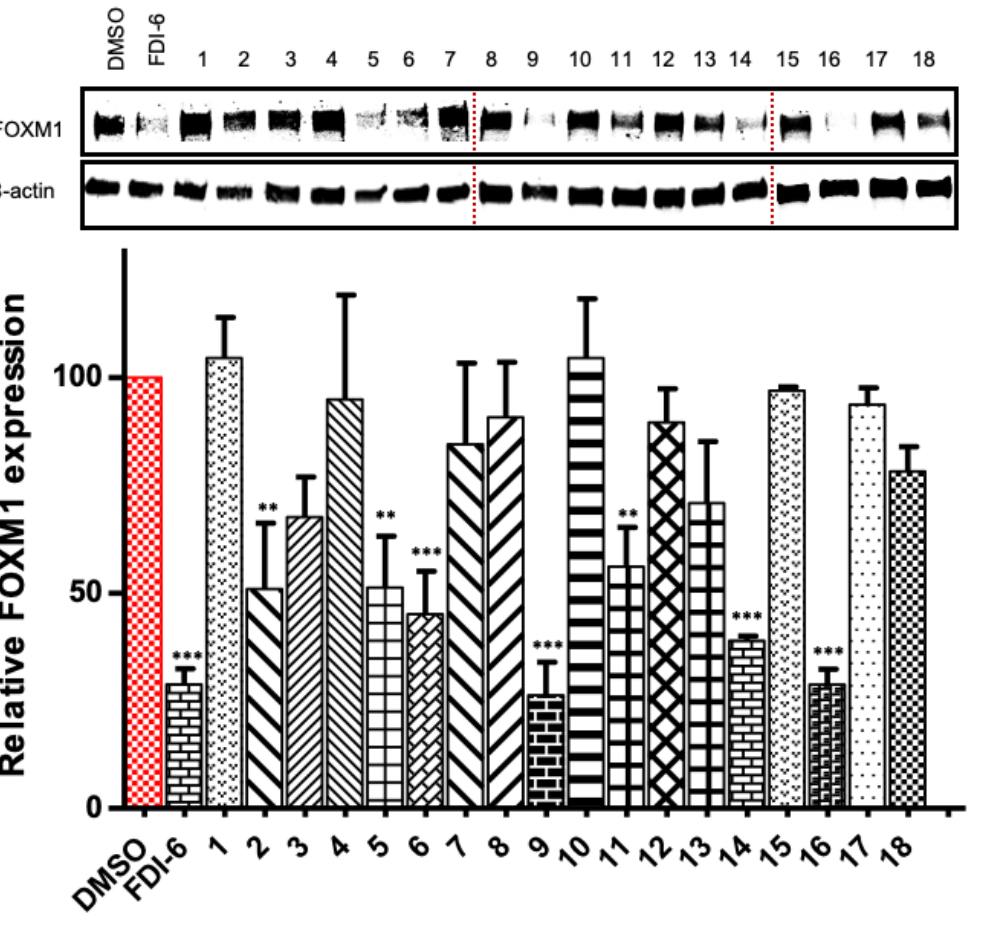
Figure 4. Western blot analysis of FOXM1 protein levels, which were decreased by the test compounds (40 µ M; 24 h; MDA-MB-231 cell line). The average values in all experiments were calculated after three independent experiments ( n = 3) and are expressed as means ± SEMs; p values were calculated by one way ANOVA (** = p ≤ 0.01; *** = p ≤ 0.001).